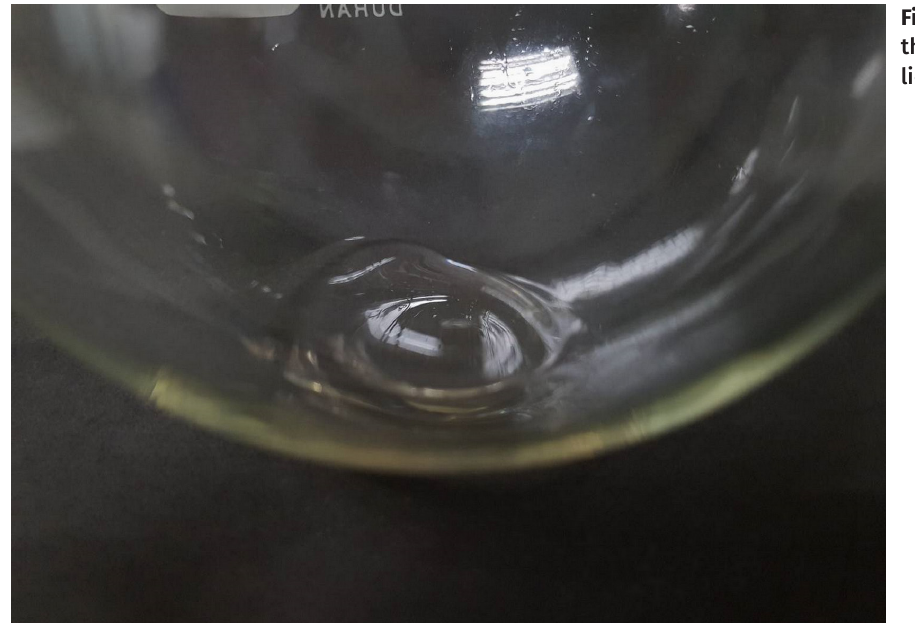
Figure 1. Appearance of the lidocaine/aspirin ionic liquid